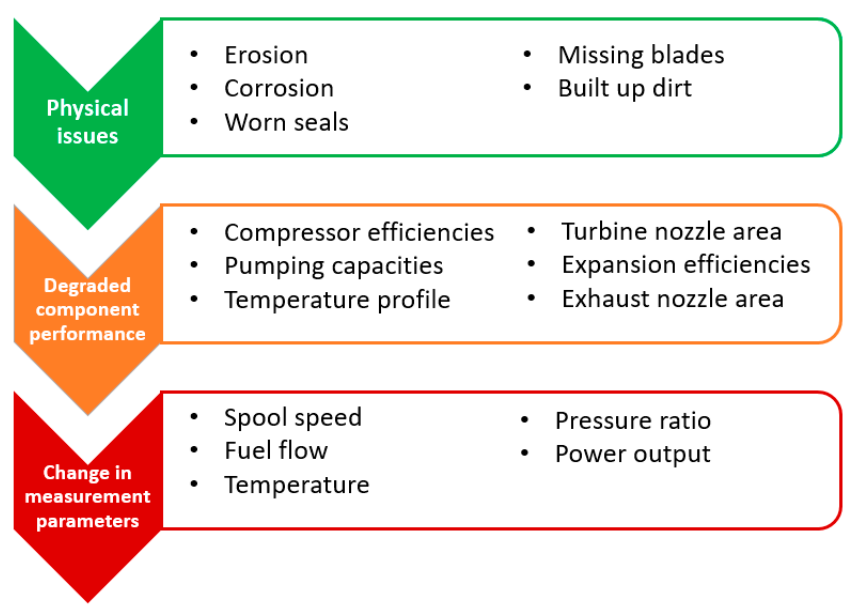
Figure 3. Gas turbines (GTEs) fault diagnostics approach [20,26].